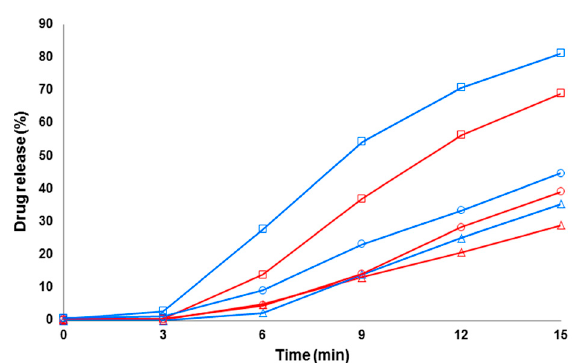
Figure 9. Early-phase dissolution of piroxicam (PRX)-loaded polydextrose (PD) fibers freely set into the dissolution baskets ( n = 6). Key: red curve—the fibers containing PRX anhydrate form I (PRX AH I) and PD (electrospun from water solution); blue curve—the fibers containing PRXAH I and PD (electrospun from a water-in-methanol 5:1 solution); Δ —purified water; ○ —pH 7.2; □ —pH 1.2. Standard deviation (SD) in each time point is less than 1.4%.